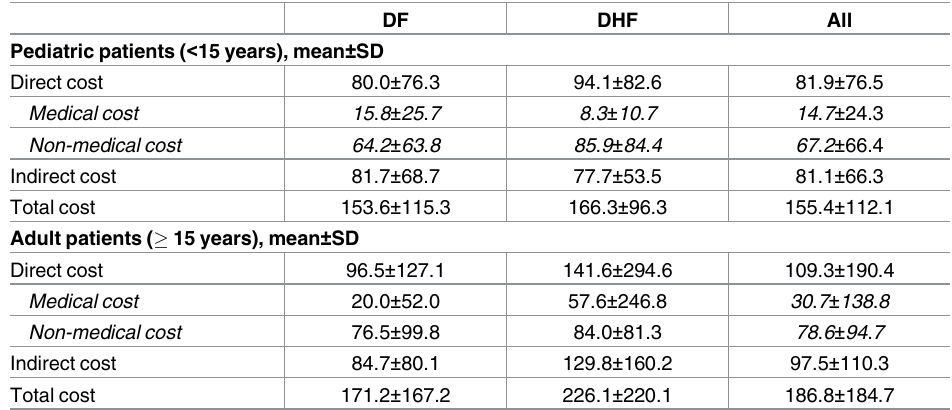
Table 5. Household costs of hospitalized dengue illness by patient age group and disease severity, Chacheongsao province, Thailand, 2015. All costs are reportedin 2015